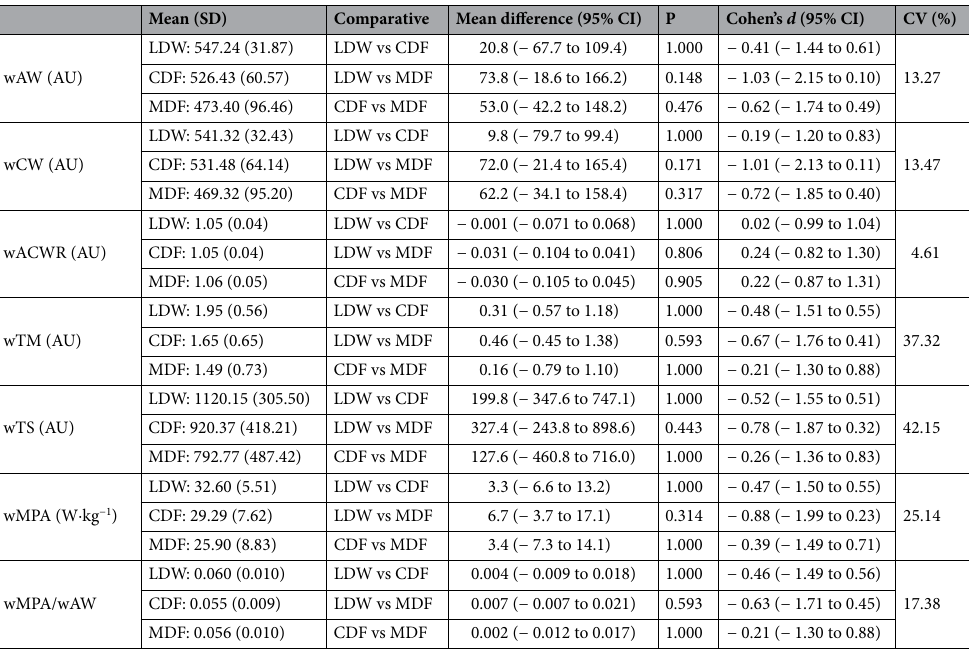
Table 1. Between-group differences in the full season weekly average for workload variables, training monotony and training strain. AU, arbitrary units; wAW, weekly average acute workload in AU; wCW, weekly average chronic workload in AU; wACWR, weekly average acute:chronic workload ratio in AU; wTM, weekly average training monotony in AU; wTS, weekly average training strain in AU; wMPA, weekly metabolic power average in watts per kilo-gram; wMPA/wAW, ratio between weekly metabolic power average and weekly average acute work-load; LDW, lateral defenders and wingers; CDF, central defenders and for-wards; and MDF, midfielders; P, P-value at alpha level 0.05; Cohen’s d (95% CI), Cohen’s d effect size magnitude with 95% confidence interval; CV, coefficient of variations for overall team as